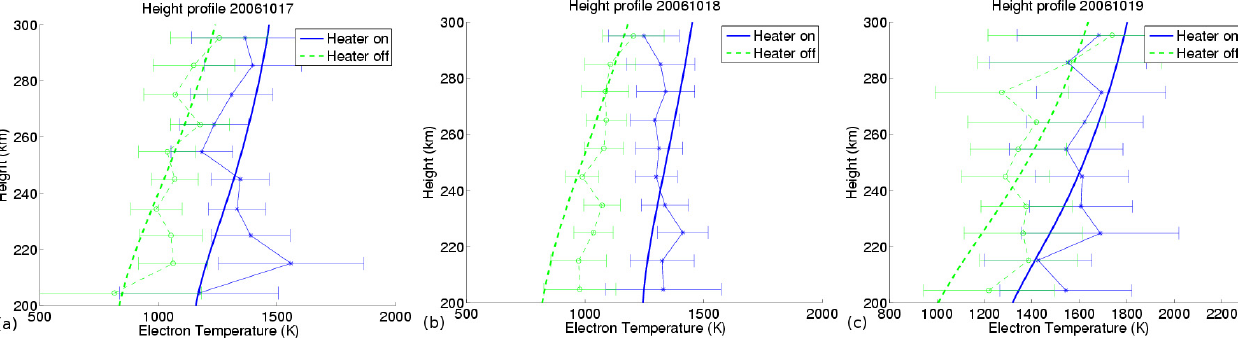
Fig. 3. Height dependence of the electron temperature for HF-on (blue) and HF-off (green), for 17 October (a) , 18 October (b) and 19 October (c) . Both observed profiles (thin line) and the solution of the energy equation (thick line) are